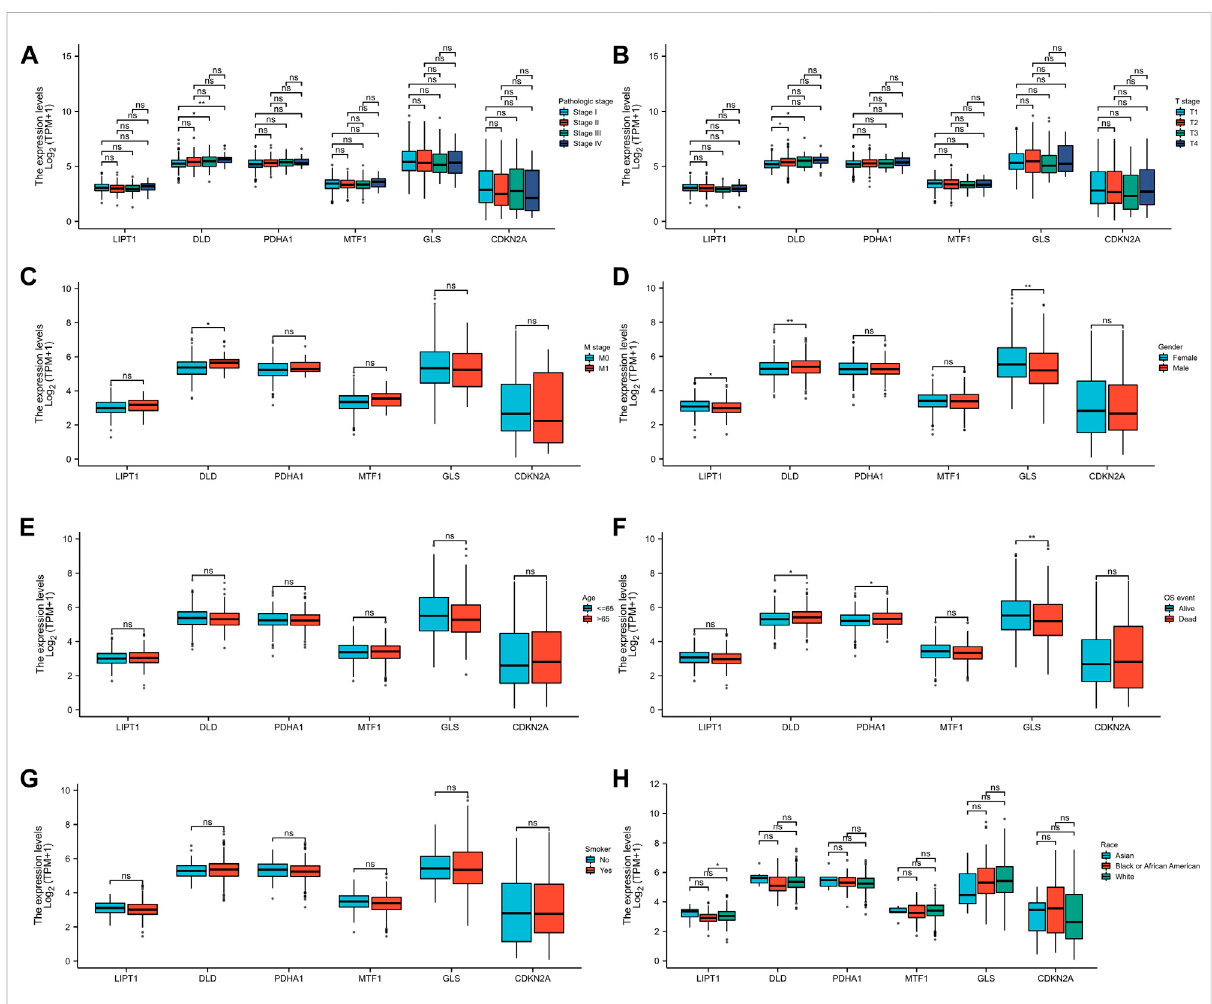
FIGURE 8 Association analysis of the six CRGs and different clinical parameters in patients with LUAD. The different clinical factors included pathologic stage (A) , T stage (B) , M stage (C) , gender (D) , age (E) , OS event (F) , smoker (G) , and race (H)